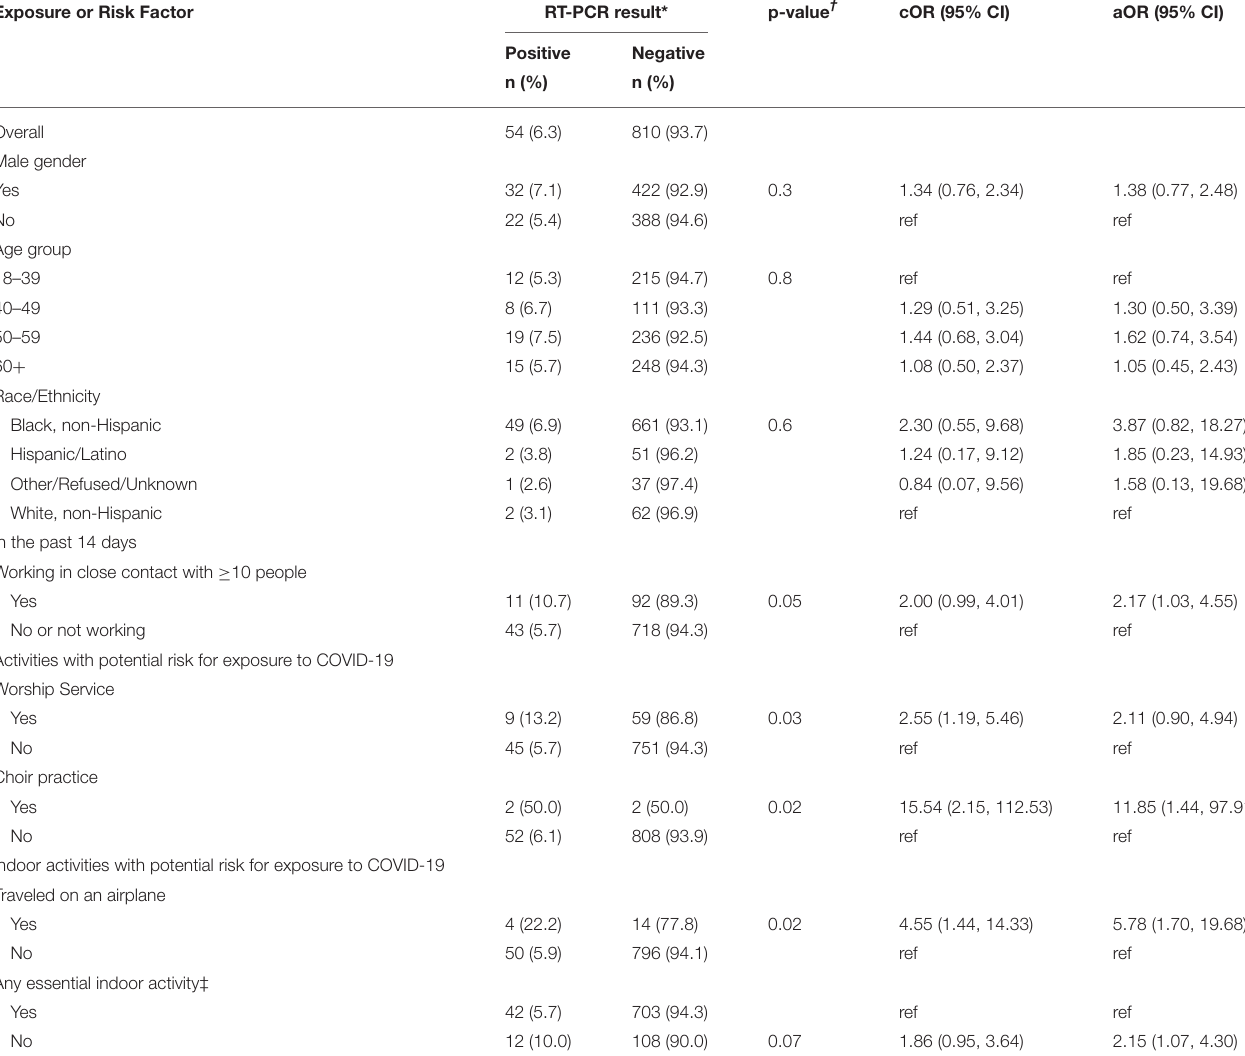
TABLE 3 | Association of risk factors for COVID-19 exposure and SARS-CoV-2 RT-PCR result among participants without a reported prior positive SARS-CoV-2 test and who reported no known close contact to a COVID-19 case; a study at a large urban, public hospital in Fulton County, GA, August-November 2020 ( n = 864). Exposure or Risk